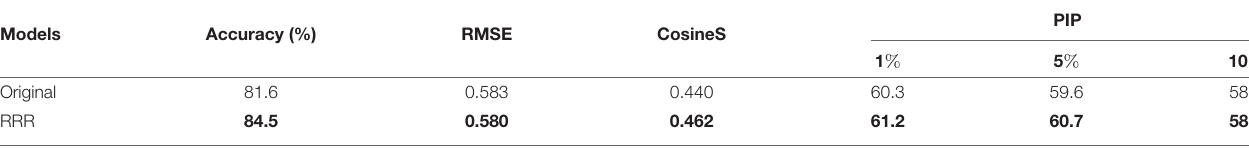
TABLE 1 | Accuracy and explanation assessment for the task of distinguishing between real and fake